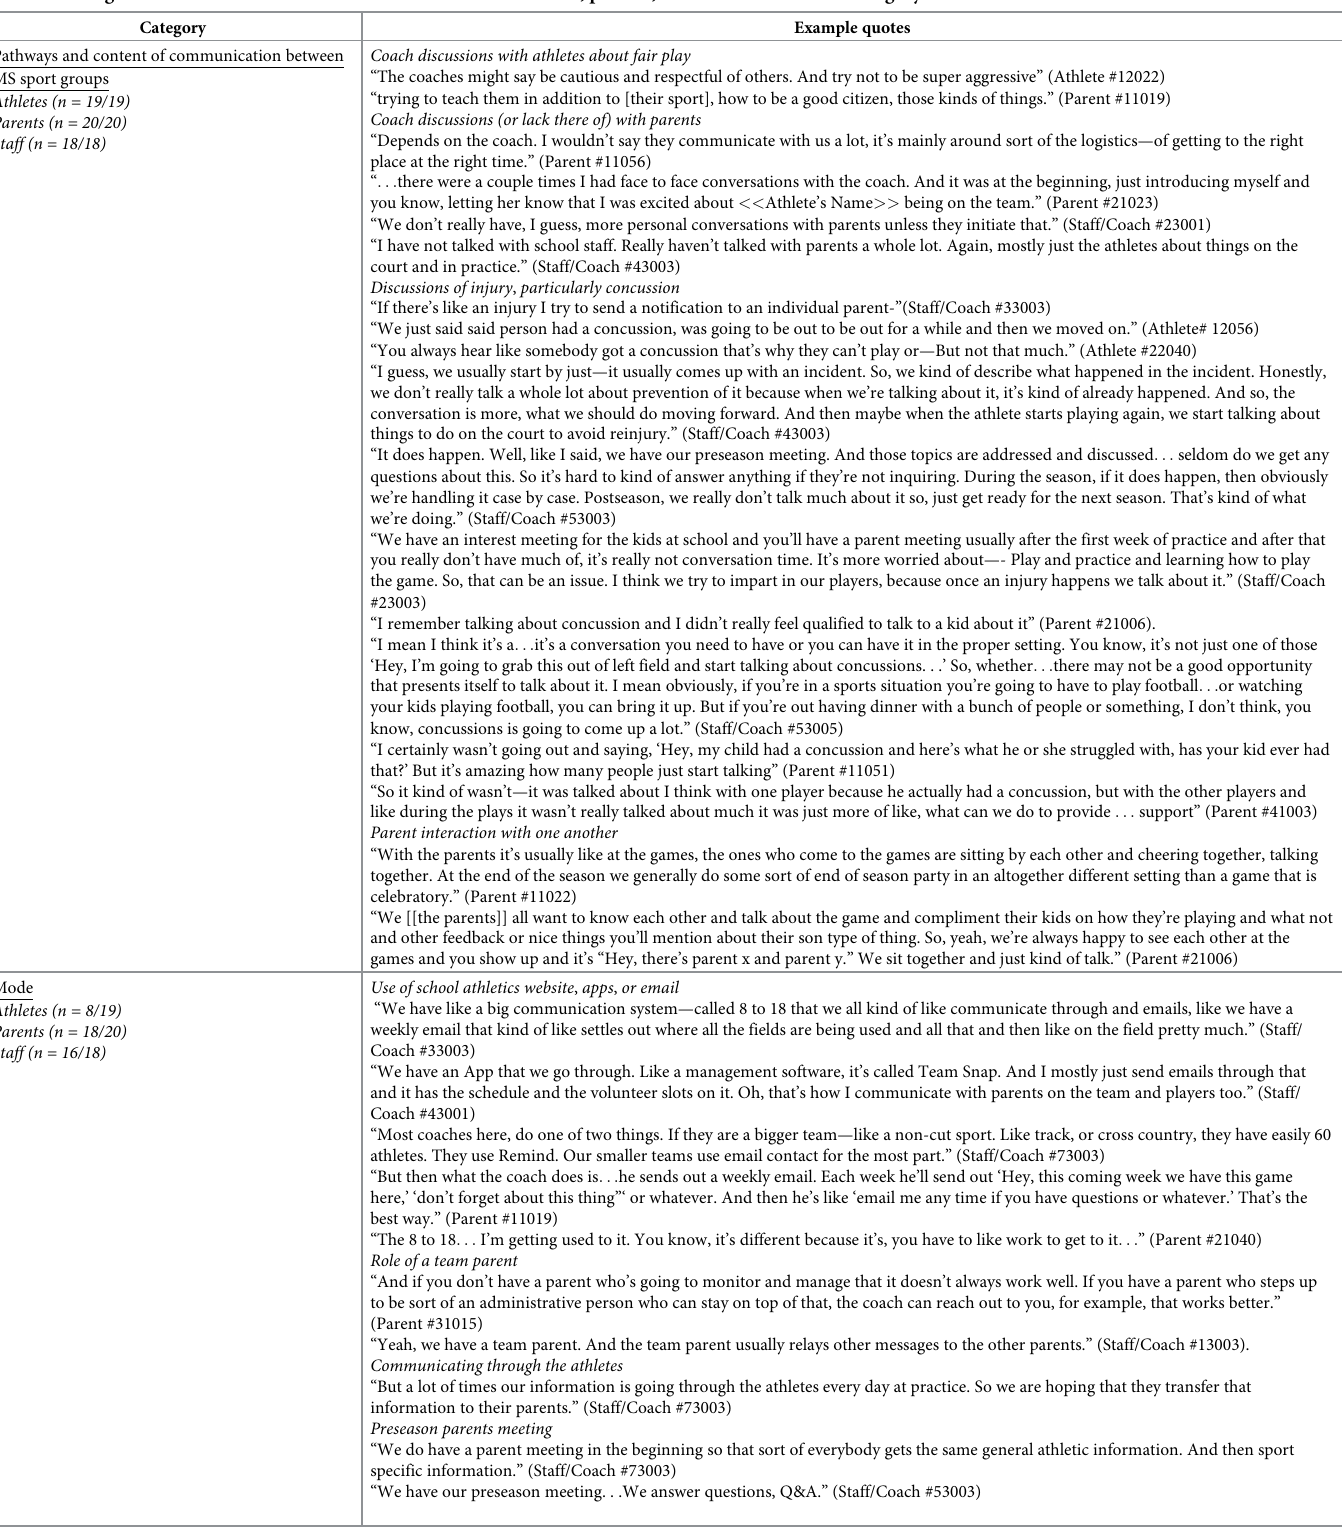
Table 4. Categories identified in interviews with middle school athletes, parents, and staff related to the category of “communication”.